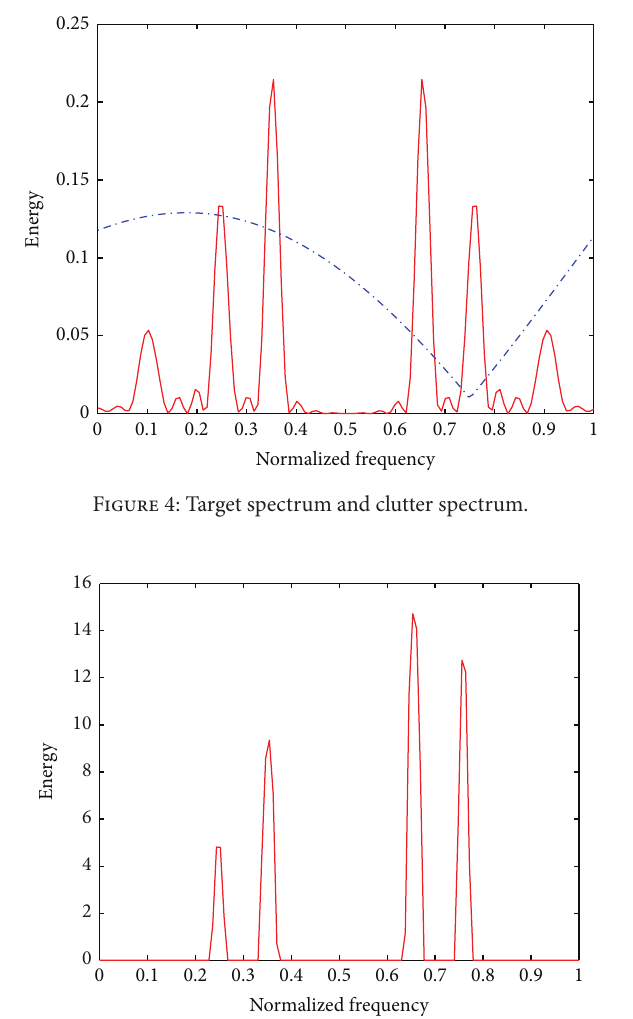
Figure 5: Energy spectrum of unconstrained waveform.